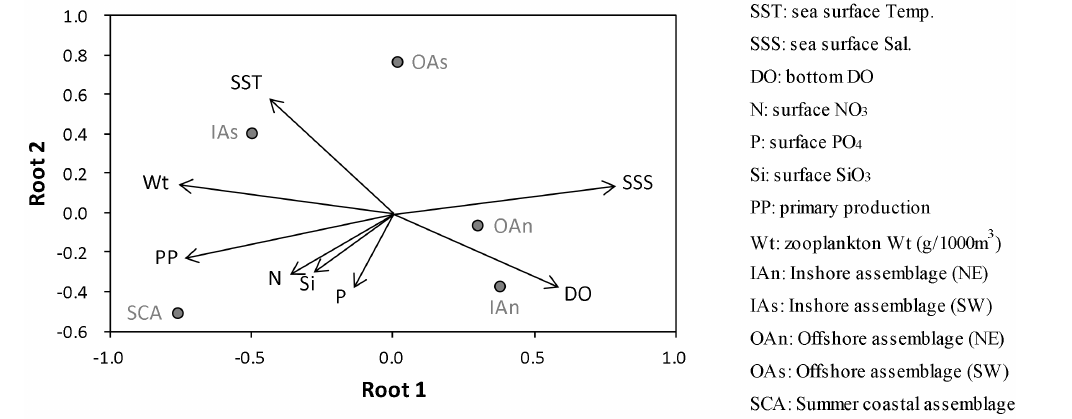
Fig. 9. Ordination diagram of canonical correlation analysis (CCA) showing the relationships between hydrographic factors and abundance of